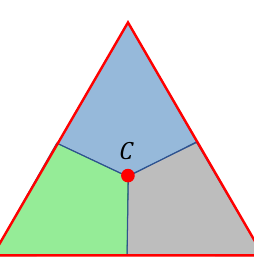
Figure 3. The centre of an equilateral triangle and the three congruent Voronoi cells, which are in different